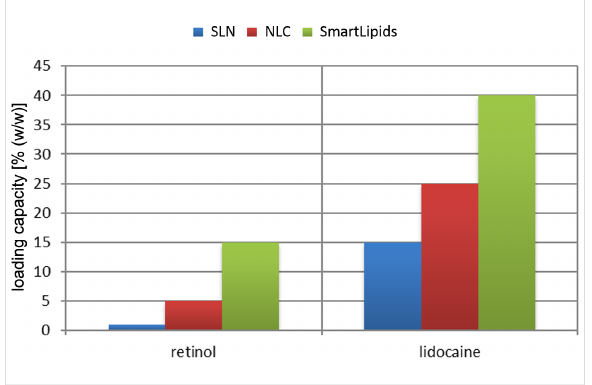
Figure 2: Maximum loading reported for SLNs, NLCs and SmartLipids for the dermal active agents retinol [11-13] (left) and lidocaine [14]